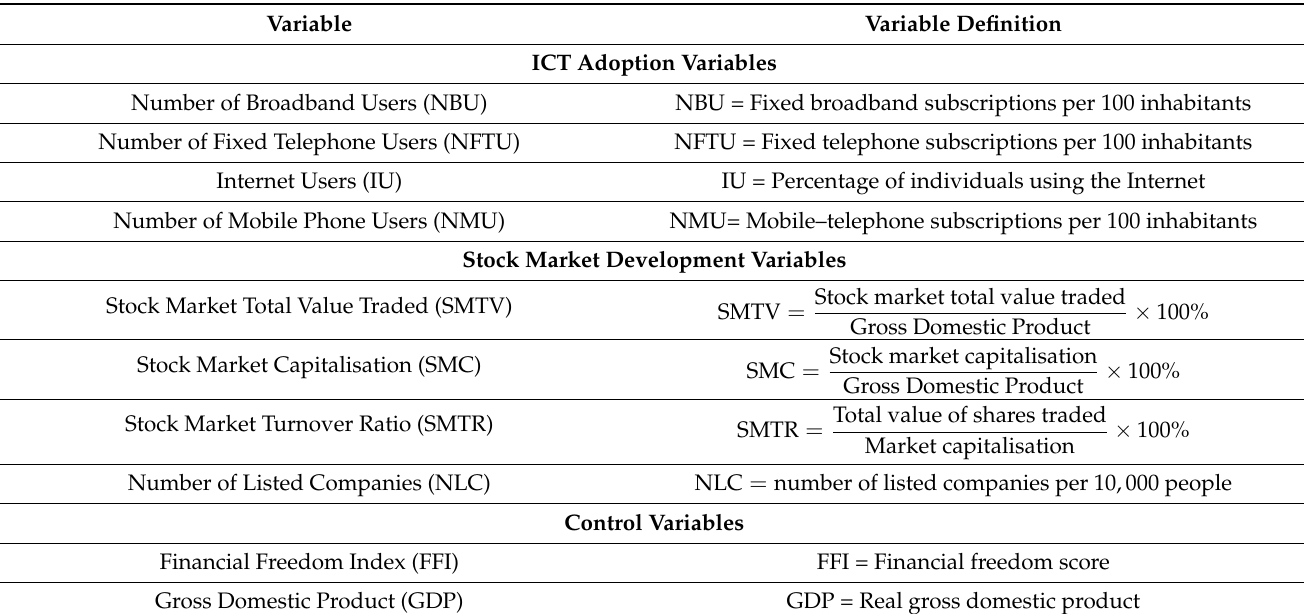
Table 3. Variable